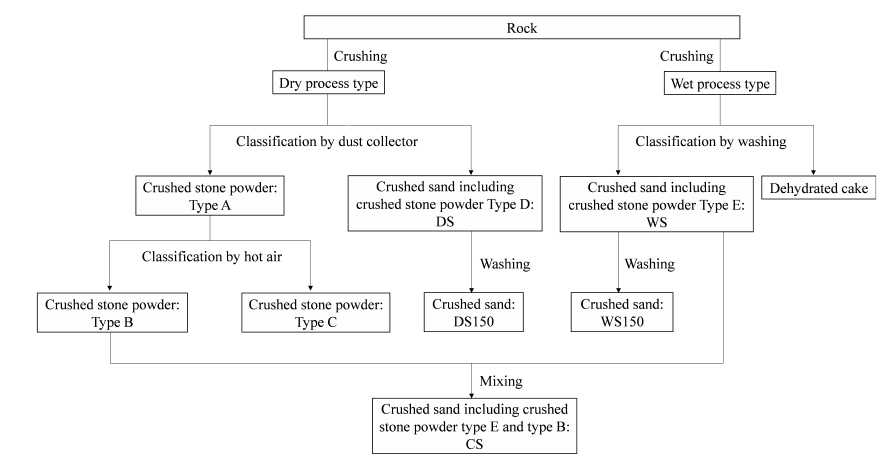
Figure 1. Production processes of crushed sands and crushed stone powders.